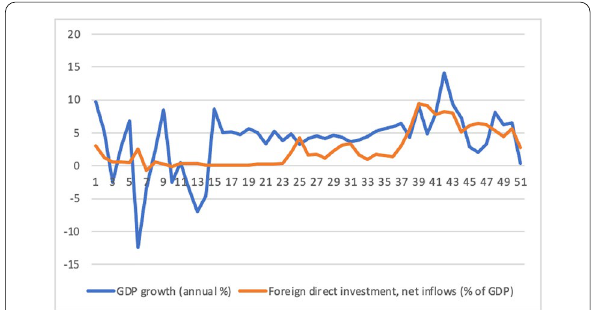
Fig. 1 GDP growth (Annual %) and Foreign direct investment. Source World Bank